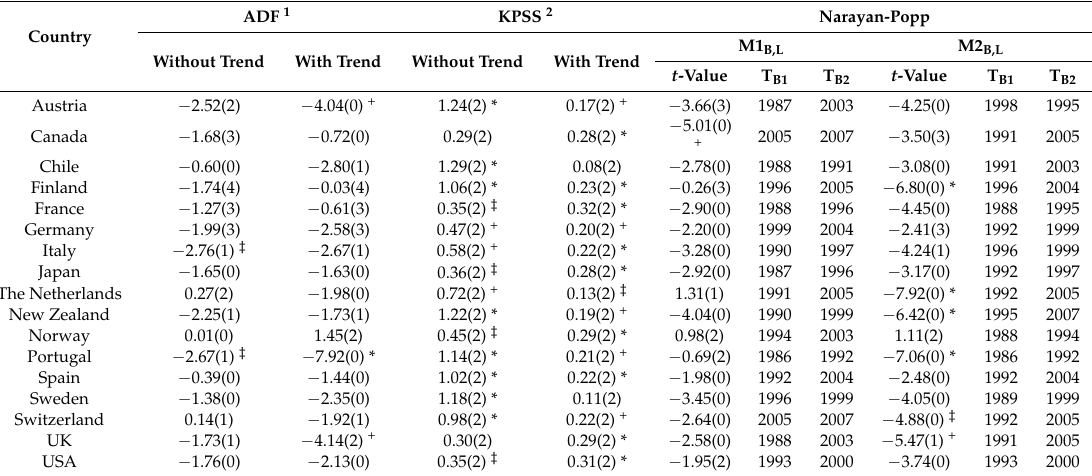
Table 1. Univariate unit root